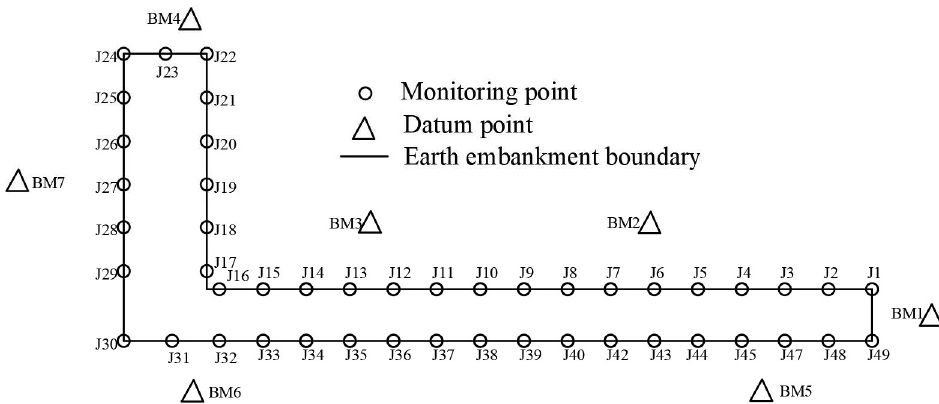
Figure 5. Layout of monitoring points.